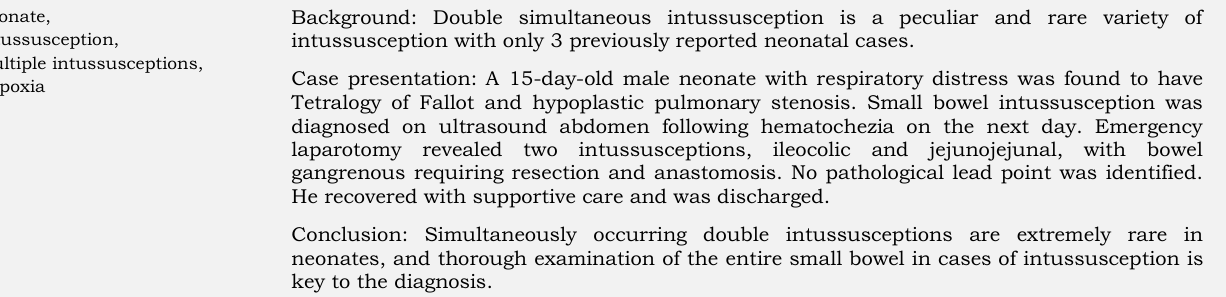
ment of inotropes to support the circulation.